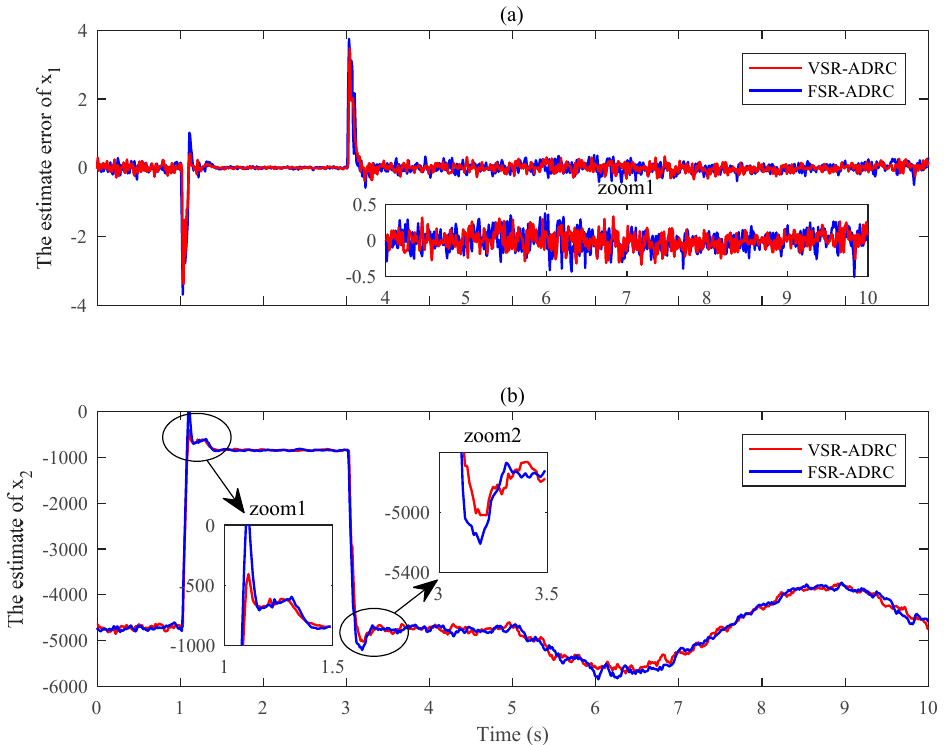
Figure 10. The estimate performance comparison of Extended State Observers (ESOs) for VSR-ADRC and FSR-ADRC during the load disturbance conditions under standard engine model: ( a ) The estimate error of x 1 ; ( b ) The estimate of x 2 .